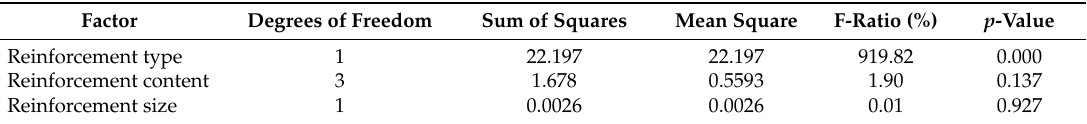
Table 3. One-way ANOVA of shrinkage in the flow direction.